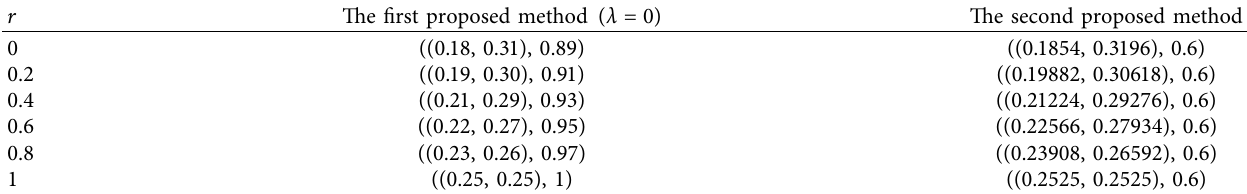
( r ) result using the two proposed methods ( λ � 0 ) . 4